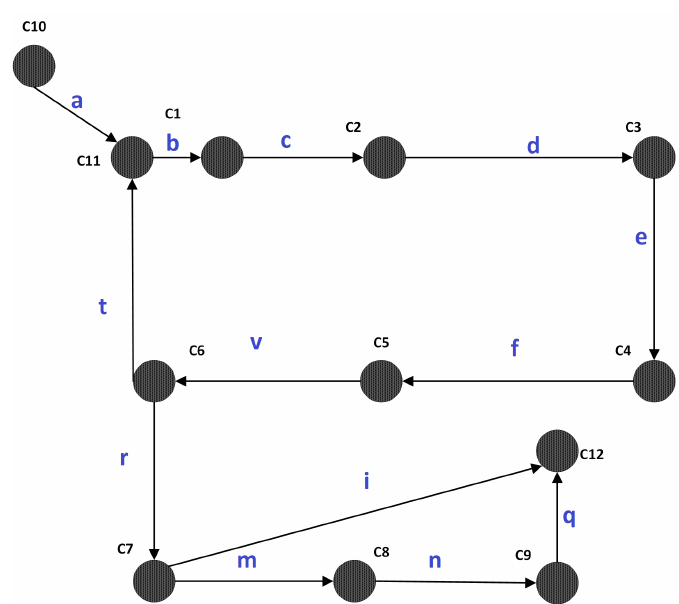
Figure 7. Example of an indoor directed